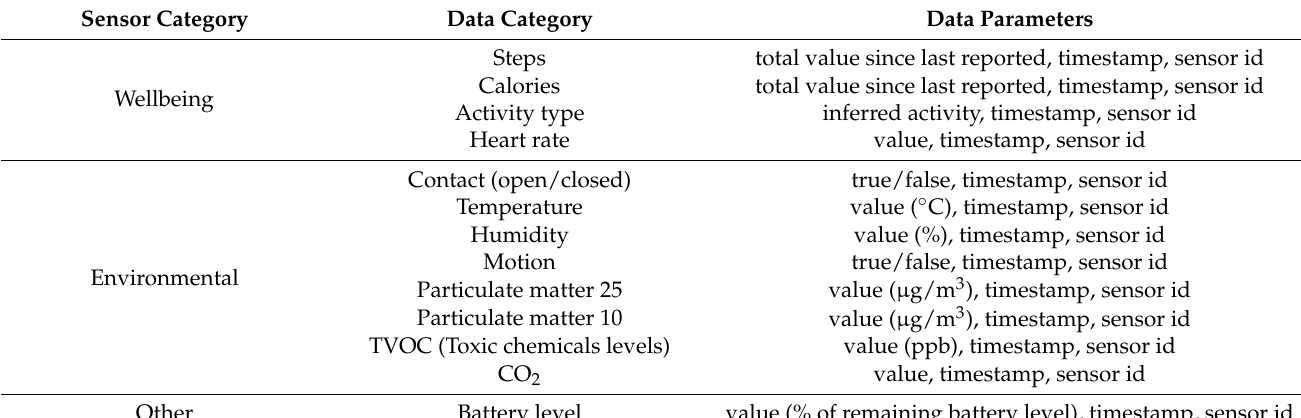
Figure 10. SmartHabits Platform-related data flow in Pharaon. Table 4. Selected arriving sensor